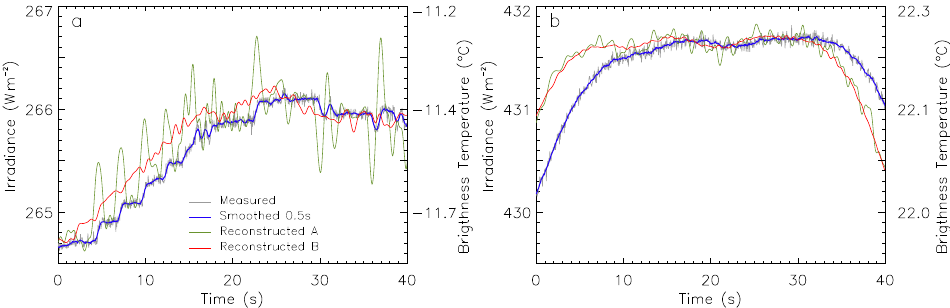
Figure 9. Comparison of the reconstruction using different low pass filter of 1s window length (A) and 5s window length (B). In (a) the airborne instrumentation using the digital AMPBOX are analyzed while in (b) the laboratory instrumentation with the analog signal amplifier CT24 are